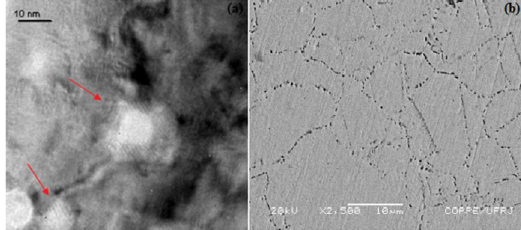
Zr IO (a) 0.97 0.03